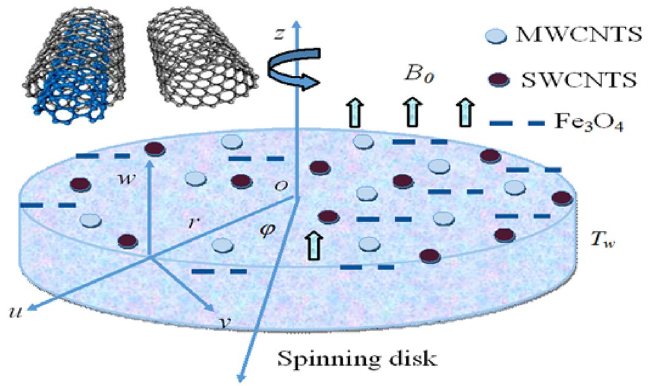
Figure 1. Spinning disk